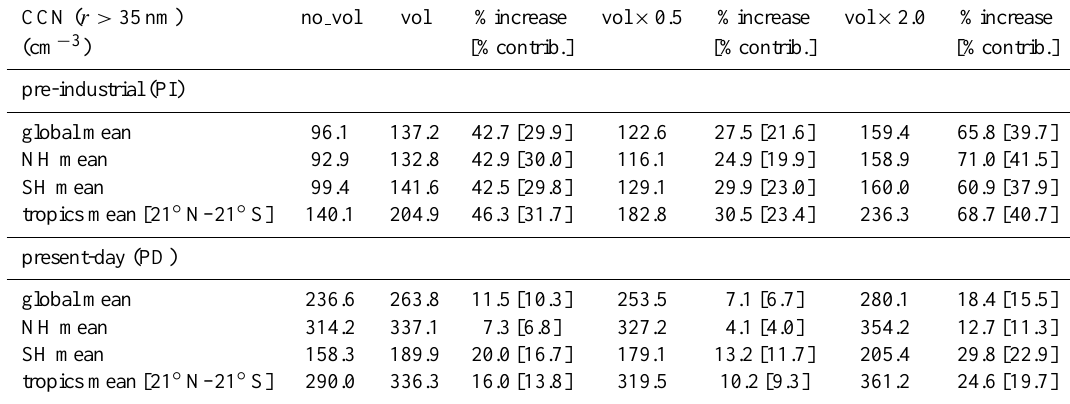
Table 1. Annual mean cloud concentration nuclei (CCN) number concentrations at low-level cloud altitude (approx. 970m above terrain or sea level) for pre-industrial (PI) and present-day (PD). The relative increases and the relative contributions always refer to the run without volcanic emissions (i.e. no vol). Here, CCN is counted as soluble particles with a dry radius larger than 35nm, which is equivalent to the particles that would activate into cloud droplets at 0.22% supersaturation (assuming sulphate